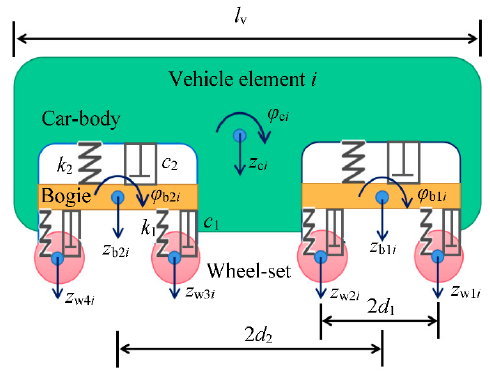
Figure 2. 2D model of the vehicle element. Table 1. Parameter values of the train subsystem [21].